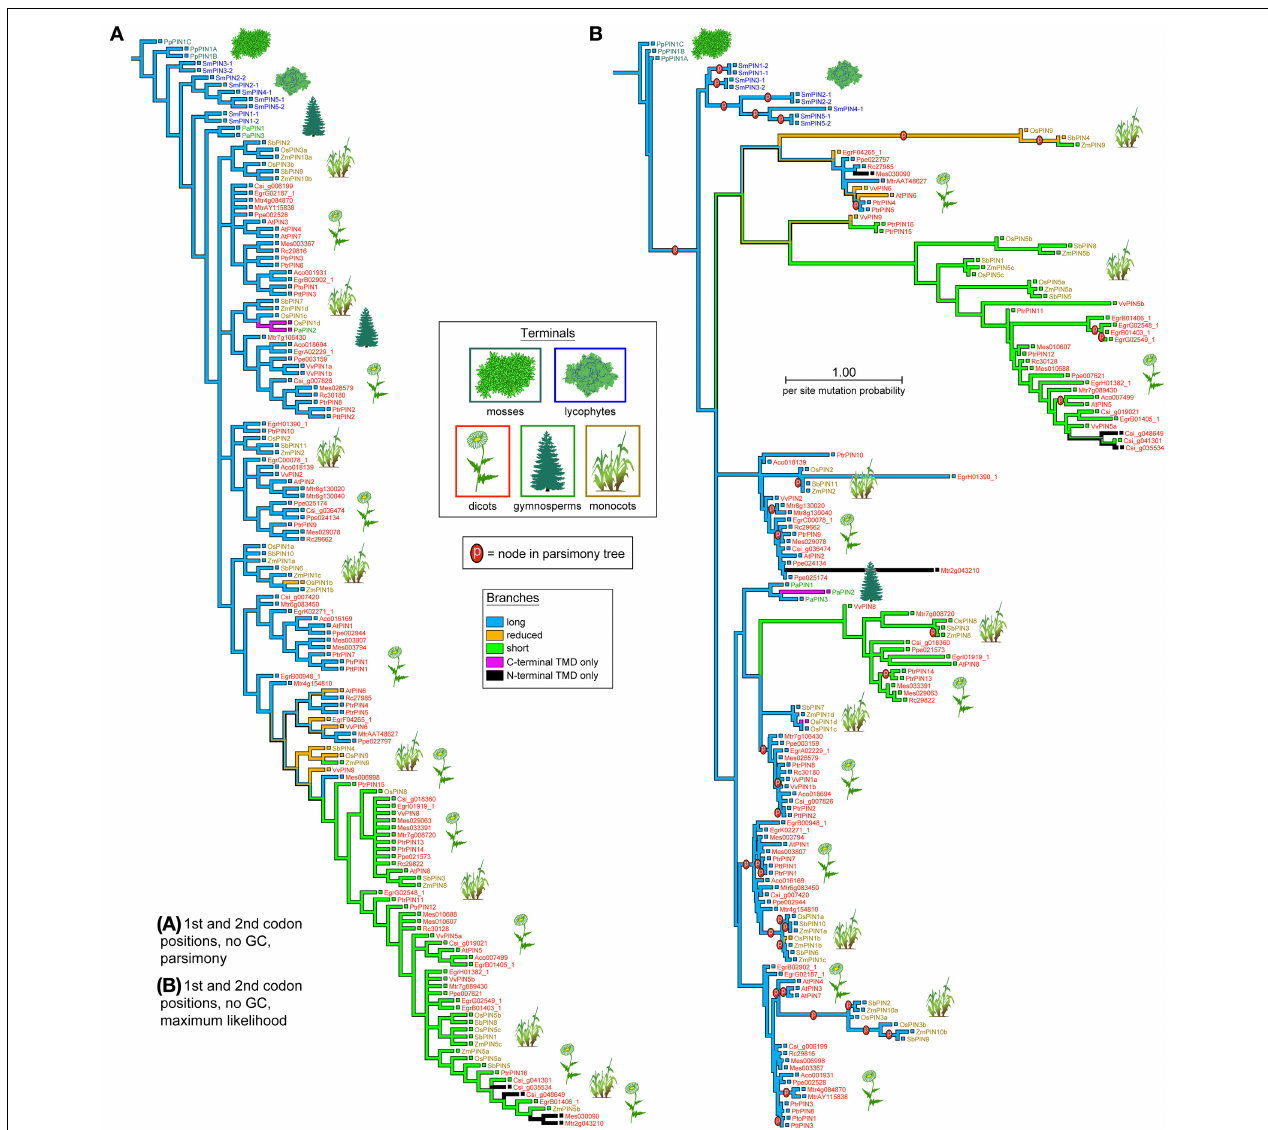
FIGURE 4 | Phylogeny of the PIN genes, using only the 1st and 2nd codon positions and with al Gs and Cs converted to “N.” The strict consensus of 85 equally parsimonious trees (A) , and the most likely tree under the GTR model (B) . Branches are colored according to gene morphology, with parsimony-based historical reconstructions in both